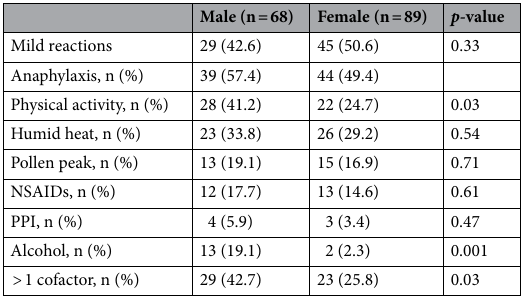
Table 1. Differences between males and females regarding the type of clinical presentation and the type of cofactors involved.